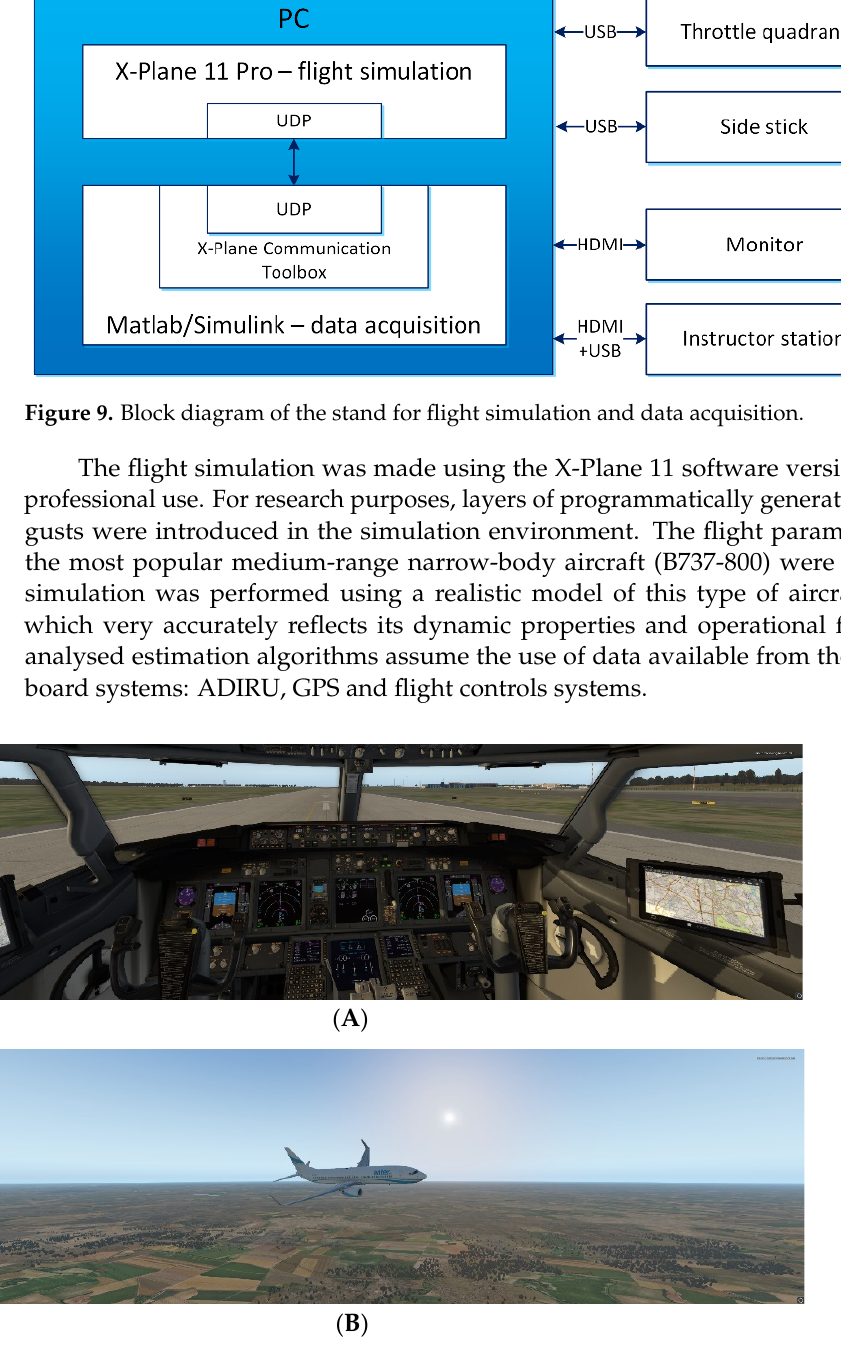
Figure 8. Stationary simulator station.